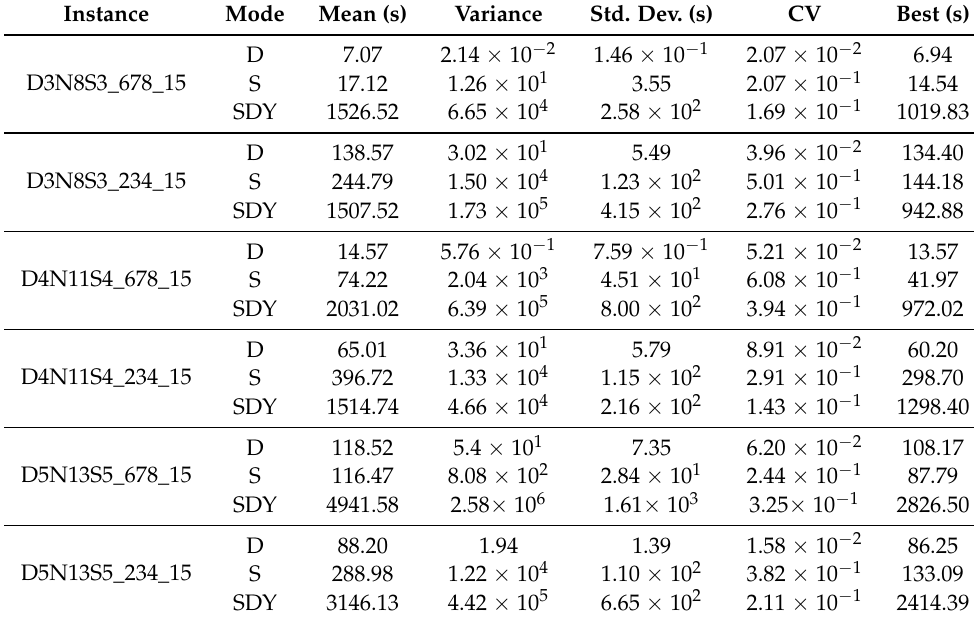
Table 7. Results of Computation Time with (Maximum) 15 Vehicles.